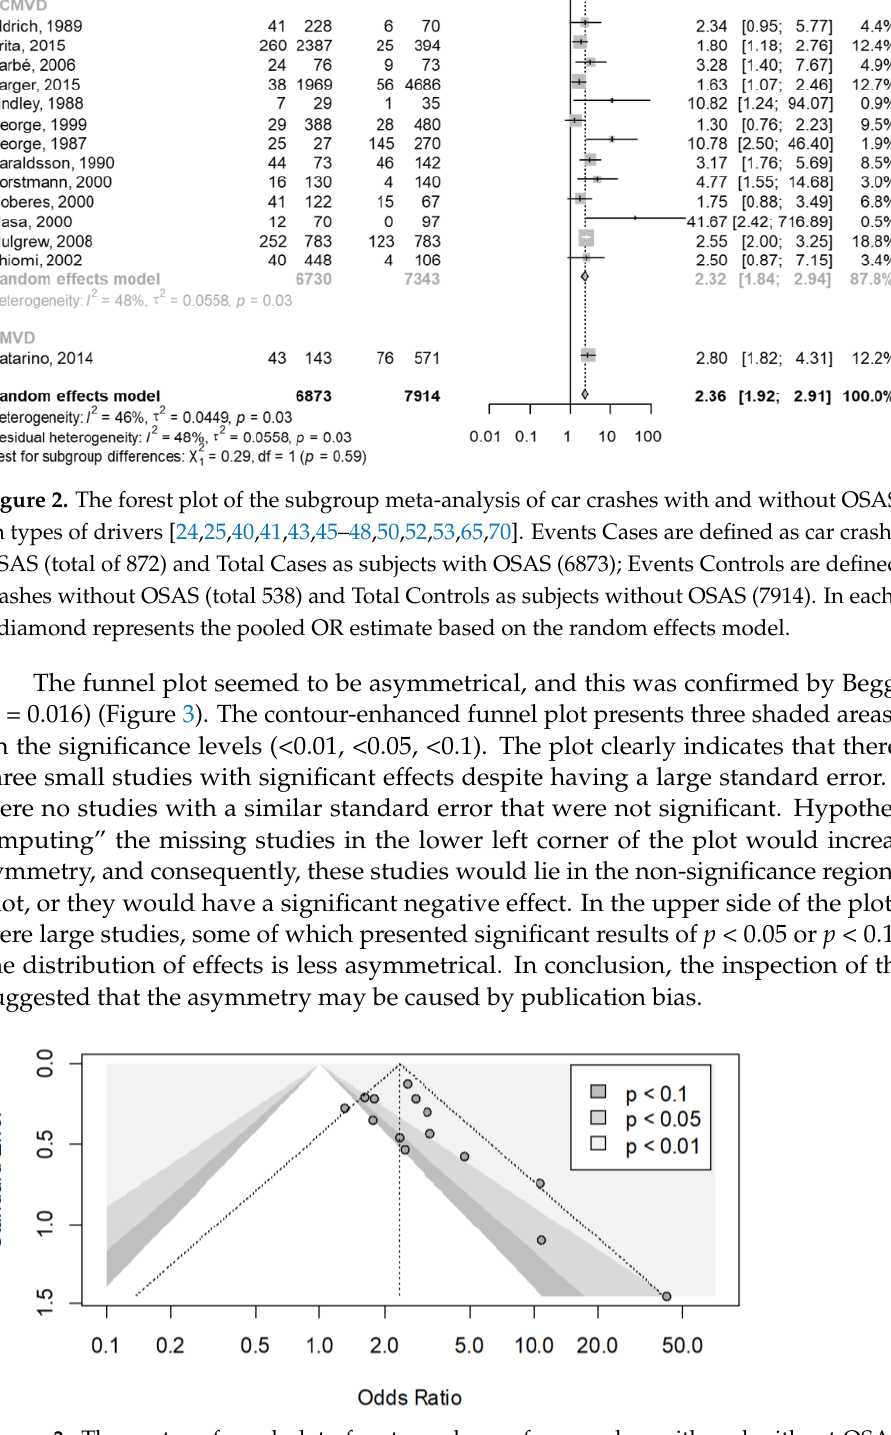
Figure 3. The contour funnel plot of meta-analyses of car crashes with and without OSAS, with contours of statistical significance at 1%, 5% and 10%. It is helpful to investigate if in a meta-analysis, some studies could have been suppressed based on their statistical significance. The plot shows clearly that there were three small studies with significant effects despite having a large standard error (right side). There were no studies with a similar standard error that were not significant (left side). Hypothetically, “imputing” the missing studies in the lower left corner of the plot would have increased the symmetry, and these studies would lie in the non-significance region of the plot or they would have a significant negative effect. In the upper side of the plot, there were large studies,